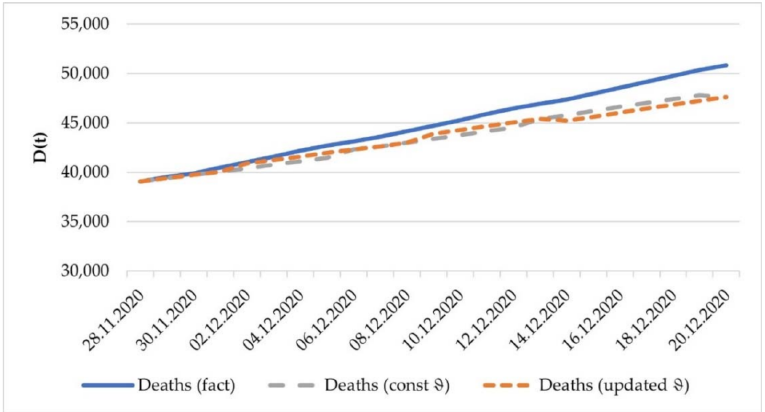
Figure 9. Dynamics of D ( t ) , the actual and modeled trajectories in the interval from 1 December to 22 December 2020, in a stationary case and at updated values of ϑ ( t ) .